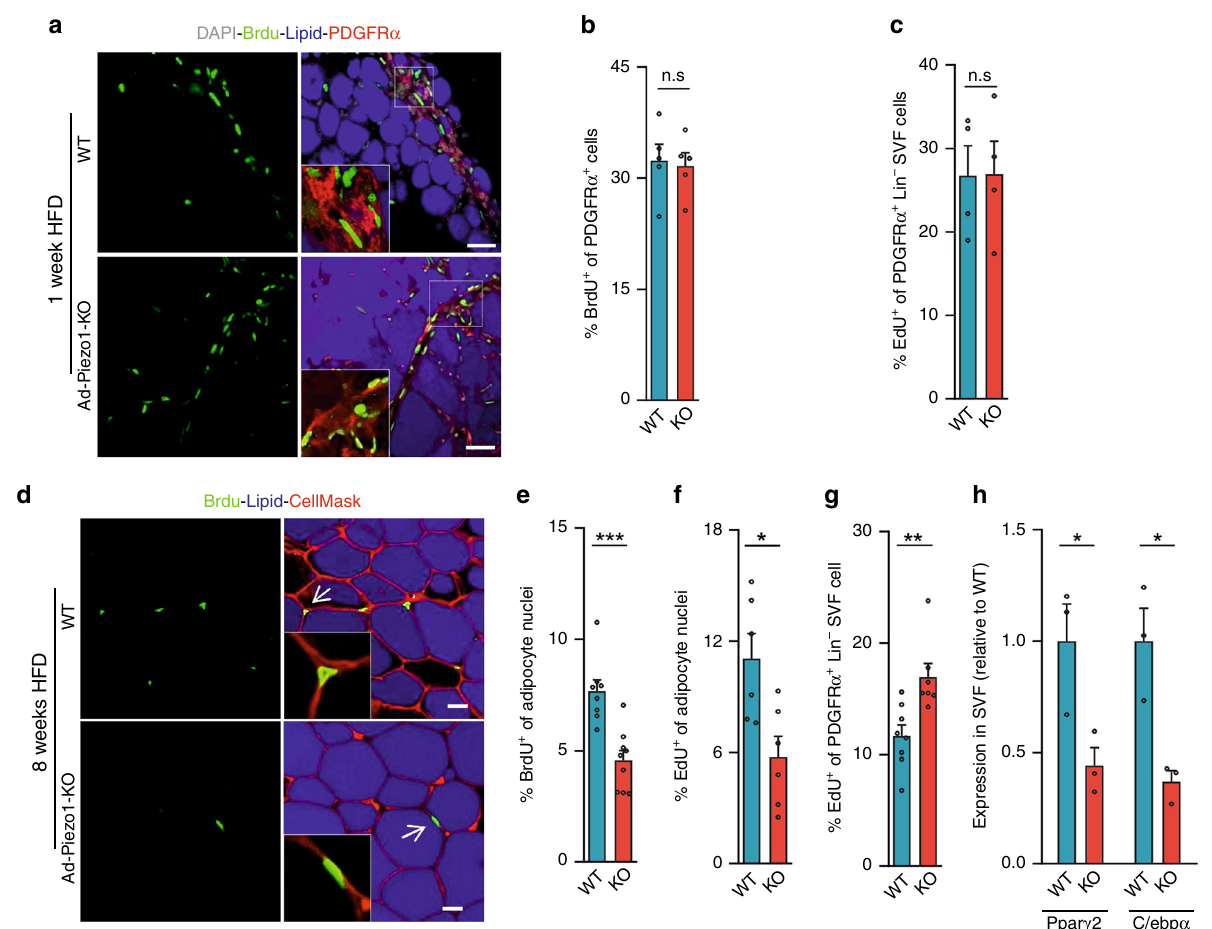
Fig. 4 Analysis of adipocyte precursor proliferation and differentiation in Ad-Piezo1-KO mice. a – g Wild-type (WT) and Ad-Piezo1-KO mice (KO) received BrdU ( a , b , d , e ) or EdU ( c , f , g ) for 1 week while feeding HFD for 1 week ( a – c ) or 8 weeks ( d – g ) started. Shown are representative images ( a , d ) and quanti fi cations ( b , e ) of immuno fl uorescence staining for BrdU in nuclei of SVF stained with an anti-PDGFR α antibody and LipidTOX (lipid) ( a , b ) or in adipocyte nuclei of vWAT ( d , e ). Tissues were stained with LipidTOX (lipid) and CellMask to visualize adipocyte plasma membranes. Insets show magni fi cations of boxed areas ( d ) or of typical adipocyte nuclei indicated by arrows ( d ); bar length: 50 μ m ( a ) and 20 μ m ( d ) ( n = 5 mice (at least 12 sections per mouse in b ), n = 8 or 9 mice (WT or KO in e ; at least 15 sections per mouse)). c , f , g Flow-cytometric analysis of EdU incorporation in PDGFR α -positive, CD31-negative and CD45-negative (Lin − ;PDGFR α + ) cells of the vWAT SVF ( c , g ) or in adipocyte nuclei ( f ) of wild-type (WT) and Ad- Piezo1-KO mice (KO) ( n = 4 mice (WT and KO in c ), n = 6 mice (WT and KO in f) , n = 8 mice (WT in g ), n = 7 mice (KO in g )). In c , f , g at least 5000 cells were analyzed per animal. h Expression of mRNA encoding Ppar γ 2 and C/ebp α in the SVF of vWAT prepared from wild-type (WT) and Ad-Piezo-KO mice (KO) fed a HFD for 16 weeks ( n = 3 mice (WT and KO in h ). Shown are mean values± s.e.m.; * P ≤ 0.05; ** P ≤ 0.01; *** P ≤ 0.001; n.s., not signi fi cant (two-tailed non-parametric Mann – Whitney U -test). Source data are provided as a Source data fi